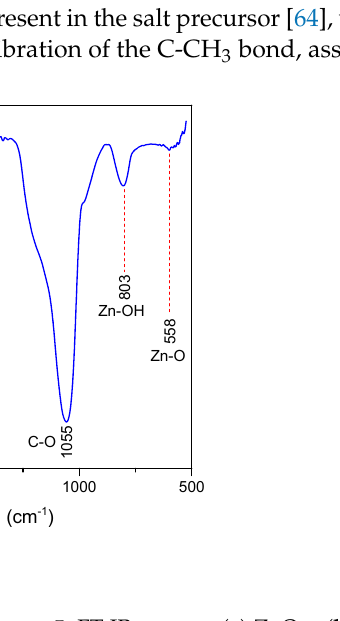
( b ) Figure 6. Nitrogen adsorption-desorption isotherms and the corresponding pore size distribution curves (inset): ( a ) ZnO N ; ( b ) ZnO A . ZnO N and ZnO A showed S BET of 0.85 and 2.24 m 2 g −1 , respectively, which are in the range of those reported by Wang et al. [69]. Hamrouni et al. [70] synthesized ZnO nano- particles (using C 4 H 6 O 4 Zn*2H 2 O as a precursor) with a BET surface area of 4.2 m 2 g −1 . It has been reported that the S BET of ZnO could be influenced by the type of precursor [71]. Wang et al. [71] reported a S BET of 91, 81, 79, and 68 m 2 g −1 for ZnO nanoparticles prepared using zinc sulfate, zinc nitrate, zinc acetate, and zinc chloride, respectively. Moreover, both ZnO N and ZnO A nanoparticles exhibited differences in the total pore volume (ZnO N of 0.01 cm 3 g −1 and ZnO A of 0.02 cm 3 g −1 ) with average pore diameters of 54.82 and 39.10 nm, respectively. Similar trends have been reported in the ZnO synthesized using differ- ent precursors (pore volume from 0.38 to 0.57 cm 3 g −1 and average pore size from 19.1 to 33.5 cm 3 g −1 ). According to Veriansyah et al. [42], differences in pore volume and pore diameter between samples could be associated with some superficial agglomerations, blocking the pores on the particle internal surface.